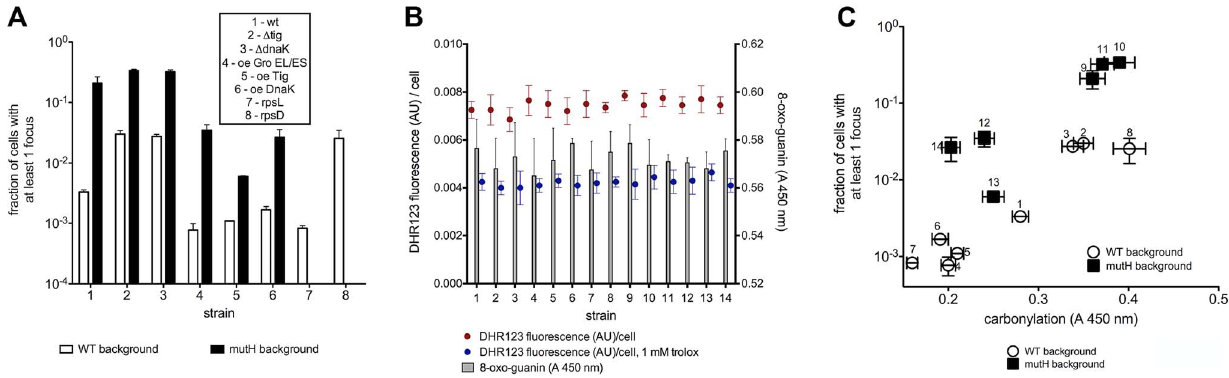
Figure 2. Mutation rate correlates with total proteome carbonylation. (a) The fraction of cells with a MutL-CFP focus (mutation rate) decreases with increasing chaperone activity and translation accuracy in wild type (white bars) and MutH deficient E.coli (black bars). (b) 8-oxo- guanine and ROS (DHR123 fluorescence) levels in each strain, in the absence and presence of 1 mM trolox, (c) Correlation between the fraction of cells with MutL-CFP foci and total proteome carbonylation. Strain identity corresponding to the numbers is listed in Figure 1D. Results are given as mean of 3 measurements, each in triplicate. Error bars represent the standard deviation. ‘‘Oe’’ stands for over-expression.